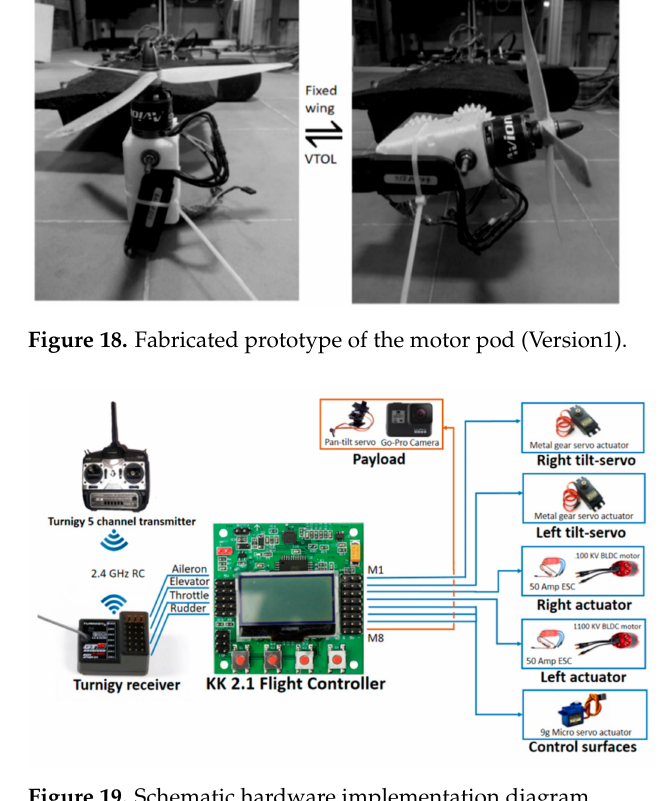
Figure 19. Schematic hardware implementation